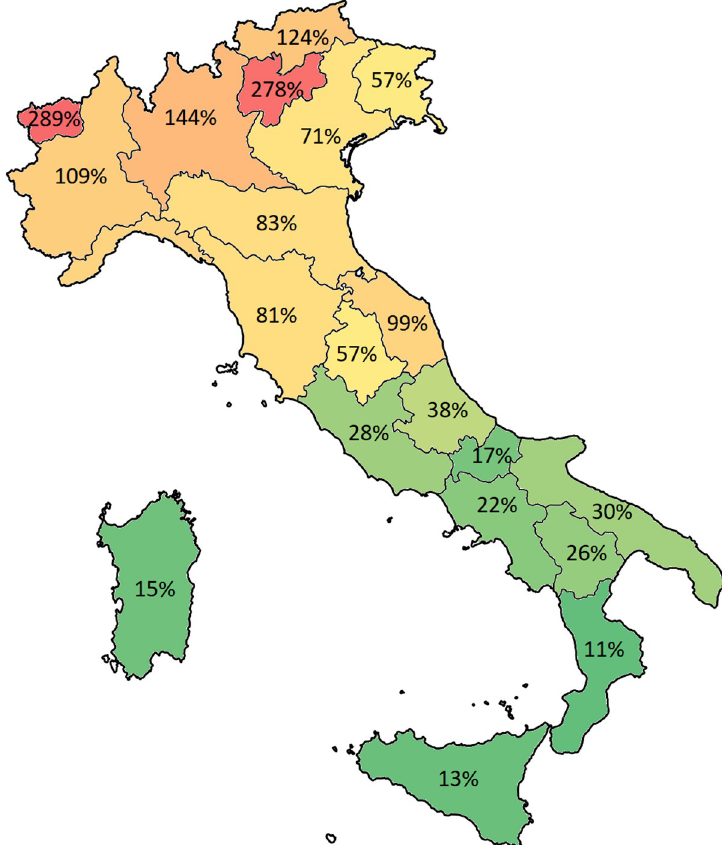
Fig 2. Percent of routinely available beds in the Intensive Care Units occupied by COVID-19 patients by region. Colours indicate the level of bed occupancy rate spanning from red (high % of beds occupied) and green (low % of beds